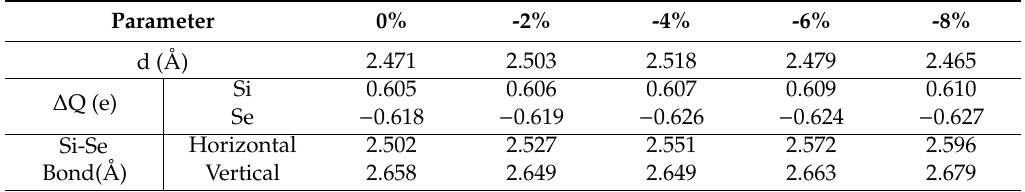
Table 4. Mulliken charge transfer ( ∆ Q) of Si atom closest to NH 3 molecule and connected Se atom, the nearest distance (d) and the length of Si-Se bond of NH 3 gas molecule adsorbed on SiSe monolayer after biaxial stress from 0% to 8%.